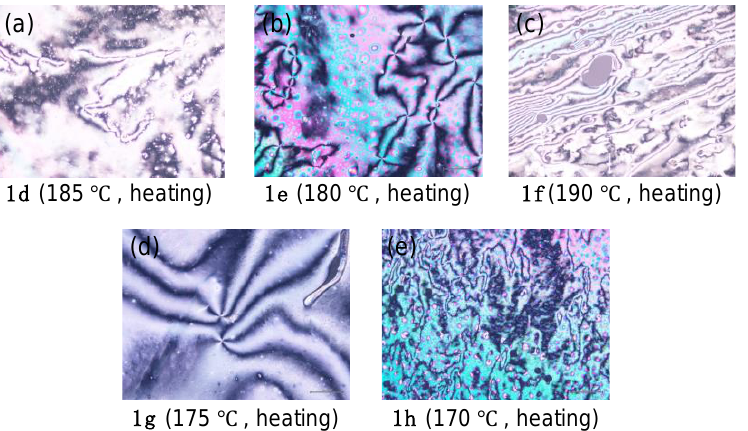
Figure 5. Optical microphotographs of ( a ) 1d , ( b ) 1e , ( c ) 1f , ( d ) 1g , and ( e ) 1h in the mesophase phase.